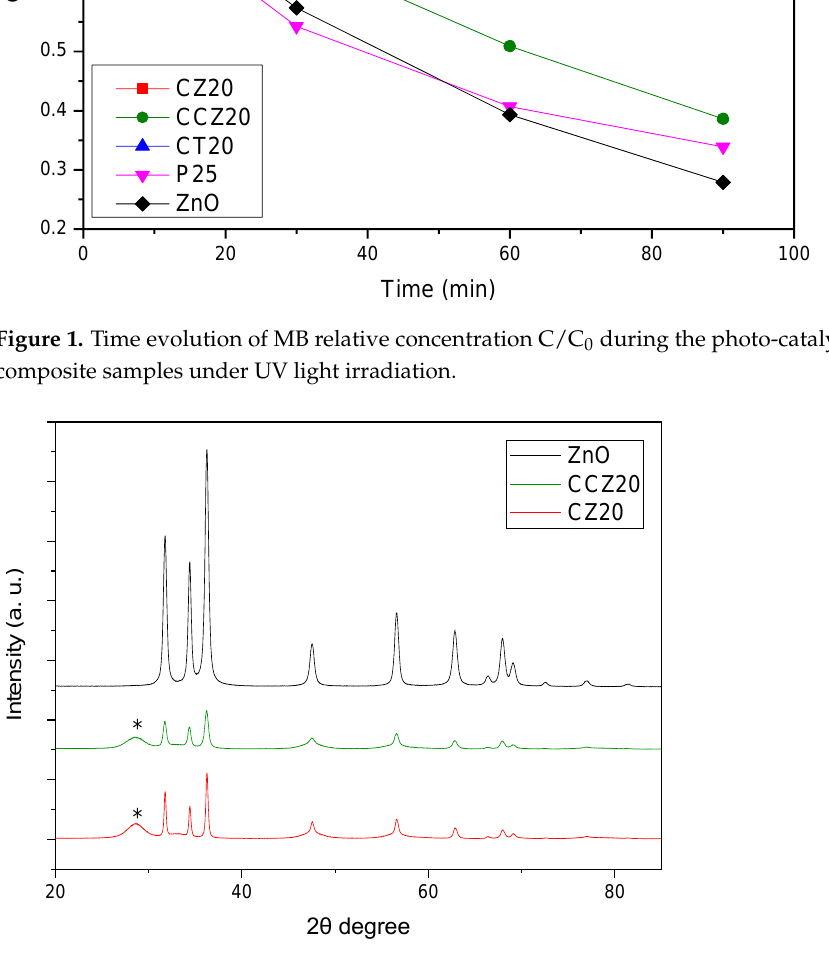
Figure 3. XRD Pattern of CT20. Blue and red lines show the cerianite- , cubic fluorite- and ana- tase-related crystallographic peaks. Raman spectroscopy is an efficient tool for the structural characterization of SC. In the Raman spectra of CZ20 and CCZ20, it was possible to recognize signals of both components (Figure 4). The low-intensity band at 100 cm − 1 is attributed to ZnO, whose characteristic pattern consisted of the two signals located at 100 cm − 1 and 438 cm − 1 [34], while the strong band at 460 cm − 1 is attributed to ceria. The asymmetric broadening of this last band indicates the presence of small CeO 2 nanoparticles dispersed in the ZnO